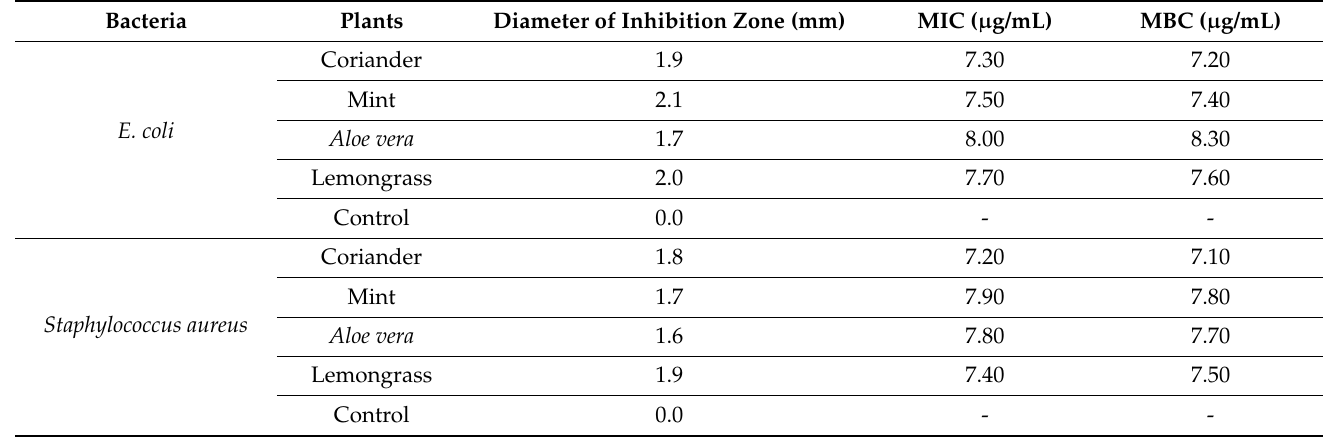
Figure 9. Antibacterial activity of Ag-NPs against E. coli ( A ) and Staphylococcus aureus (B). Table 1. The diameter of Zone of Inhibition (mm), MIC value ( µ g/mL), and MBC value ( µ